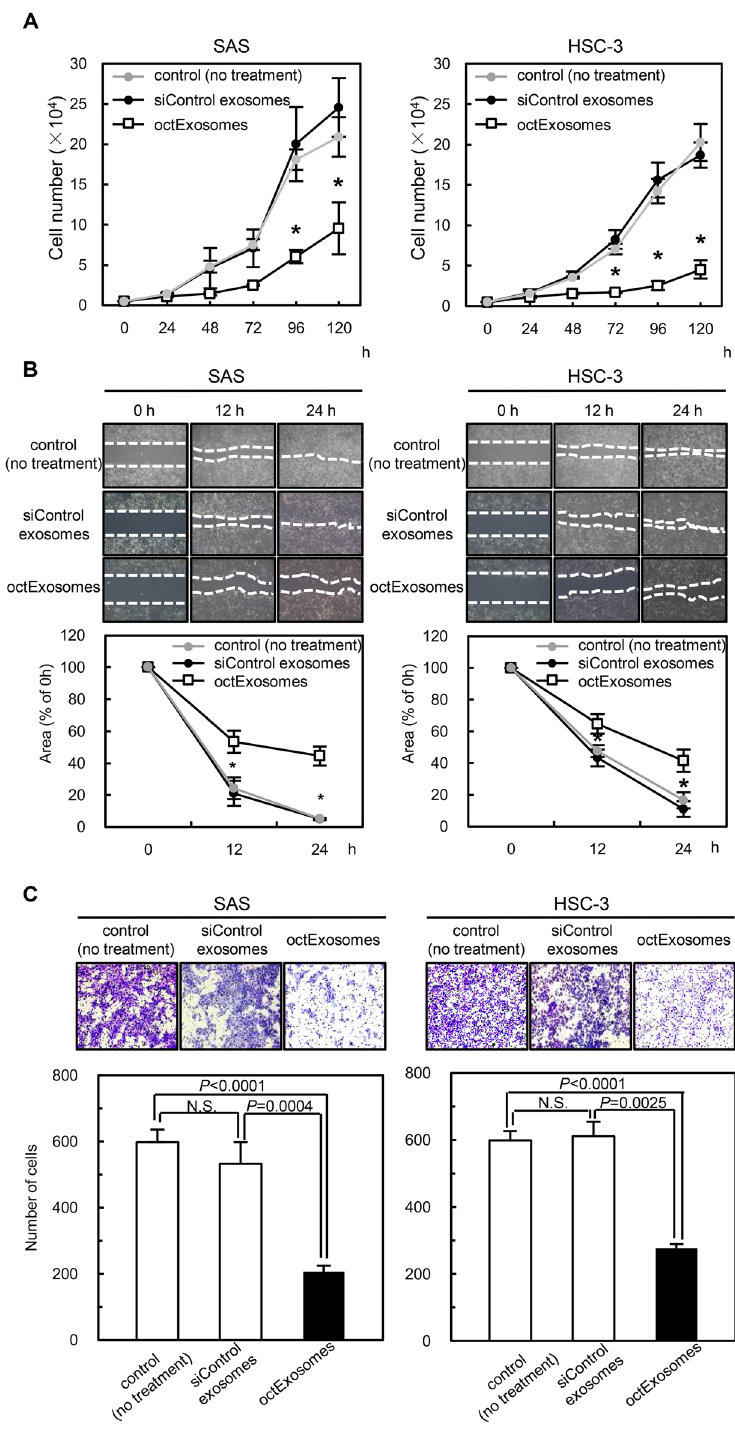
Figure 4. Tumor progression assay of OSCC cells transfected with octExosomes. ( A ) Proliferation assays for SAS and HSC-3 cells treated with octExosomes or siControl exosomes. ( B ) Migration assays for SAS and HSC-3 cells transfected with octExosomes or siControl exosomes. ( C ) Invasion assays for SAS and HSC-3 cells transfected with octExosomes or siControl exosomes. (Data are presented as mean ± SD. N = 3. * P < 0.05). Note that the silencing of LCP1 drastically reduced the proliferation, migratory and invasive abilities of SAS and